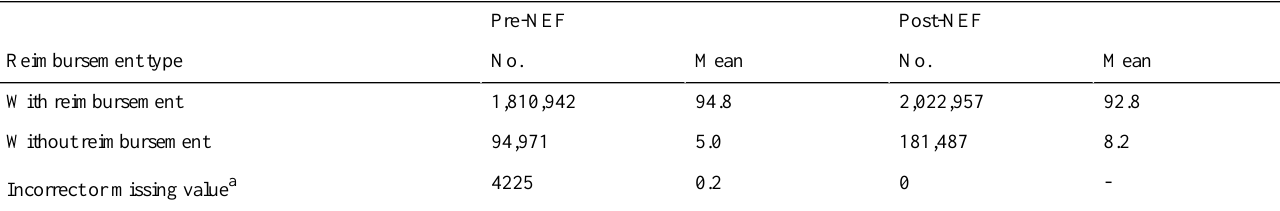
Table 6. Number of prescriptions with prescribed reimbursement and mean prescribed reimbursement per prescription in pre-NEF and post-NEF samples.